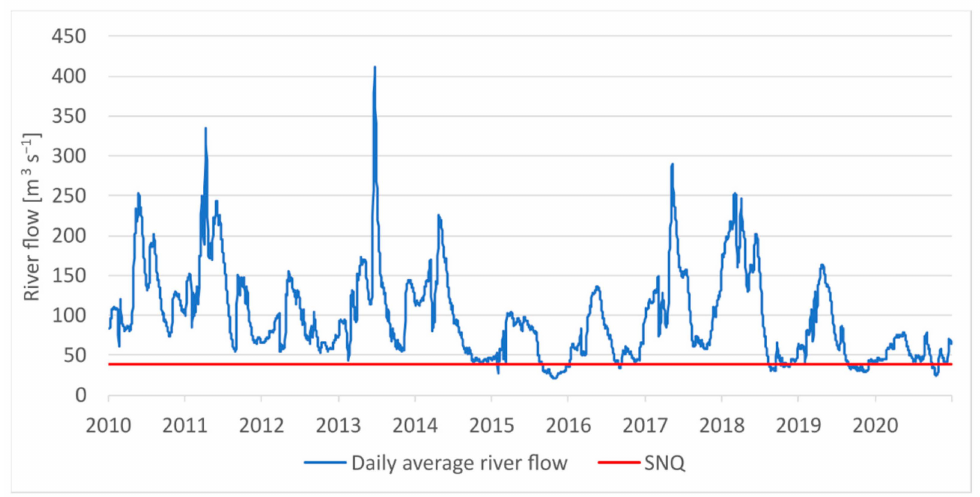
Figure 9. The flow of the Narew River at the Nowogr ó d water gauge station in the hydrological years 2010 − 2020.